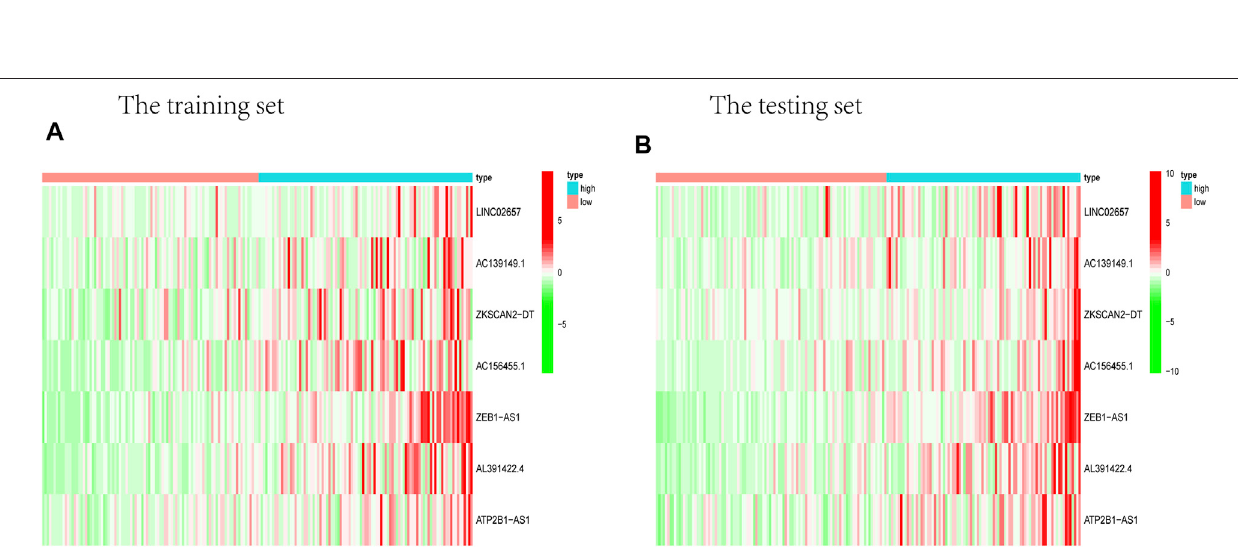
Frontiers in Genetics |